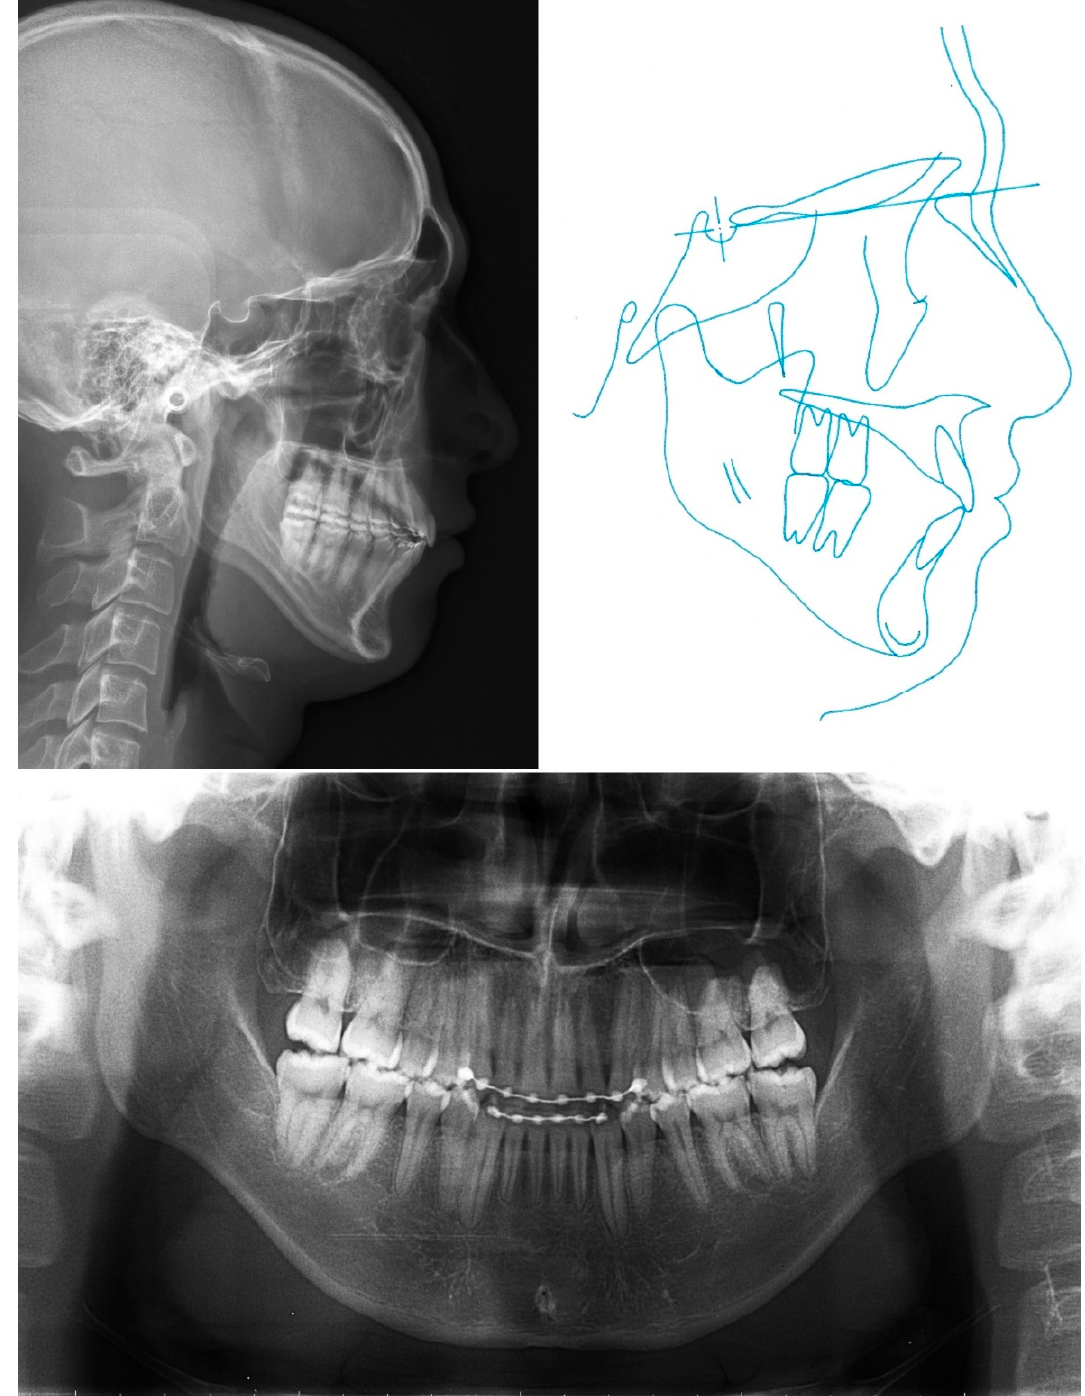
Figure 12. Lateral cephalometric, cephalometric tracing, and panoramic radiographs after 2 years of retention.